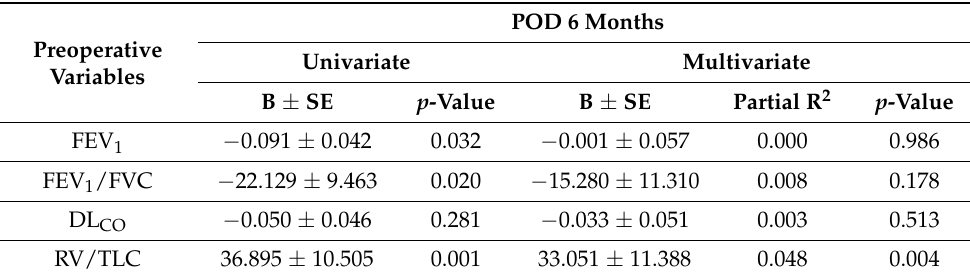
Table 4. Correlation of differences (postoperative FEV 1 minus ppoFEV 1 ) with preoperative PFT parameters and postoperative FEV 1